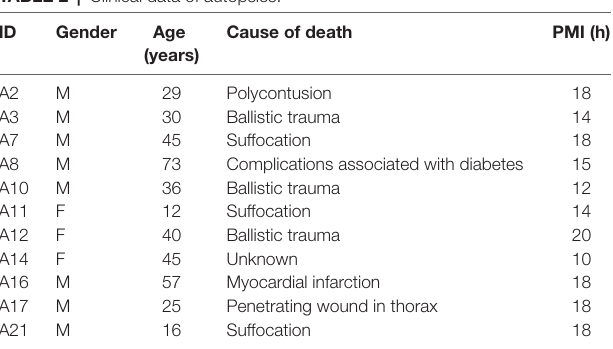
TABLE 2 | Clinical data of